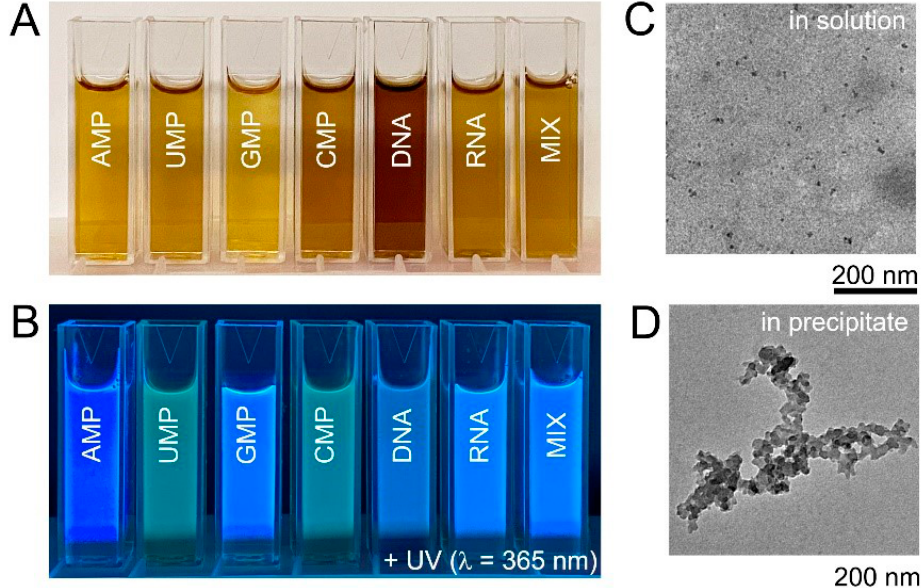
Figure 2. Biodots synthesized from nucleic acids. ( A ). Photographic images of 1% biodot solutions prepared by the HT treatment of AMP, UMP, GMP, CMP, DNA, RNA, and a mixture (MIX) of AMP, UMP, GMP, and CMP nucleotides containing 0.25% of each. ( B ). Corresponding photographs of biodot solutions in the dark under 365 nm UV irradiation. ( C ). Typical TEM image of biodots prepared from DNA by HT treatment. ( D ). Typical TEM image of aggregates in the precipitate formed during DNA HT treatment.